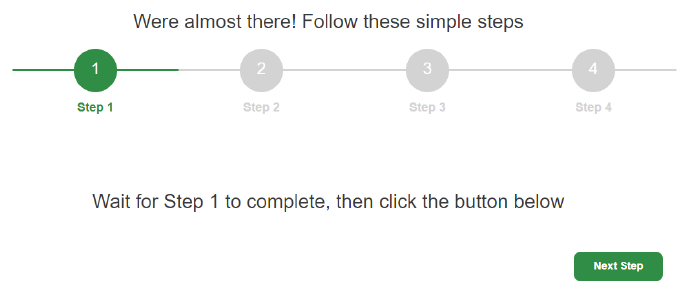
Figure 6. Completion of Step